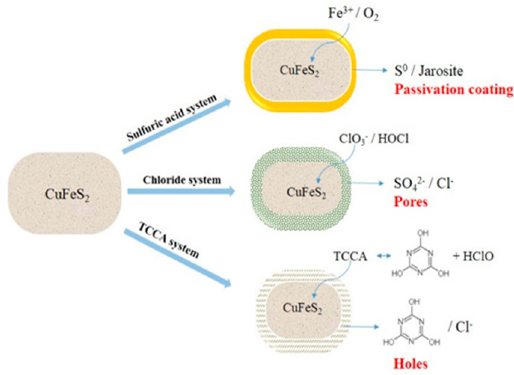
Figure 10. The proposed mechanisms of chalcopyrite leaching in different systems.